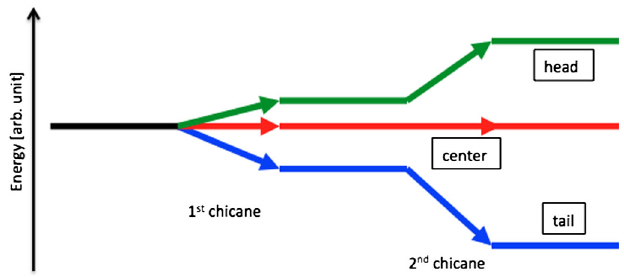
FIG. 6. A sketch of expected energy variation along the two- chicane compressor. Because of the higher peak current, the CSR wakes in the second chicane are stronger and a larger energy change is